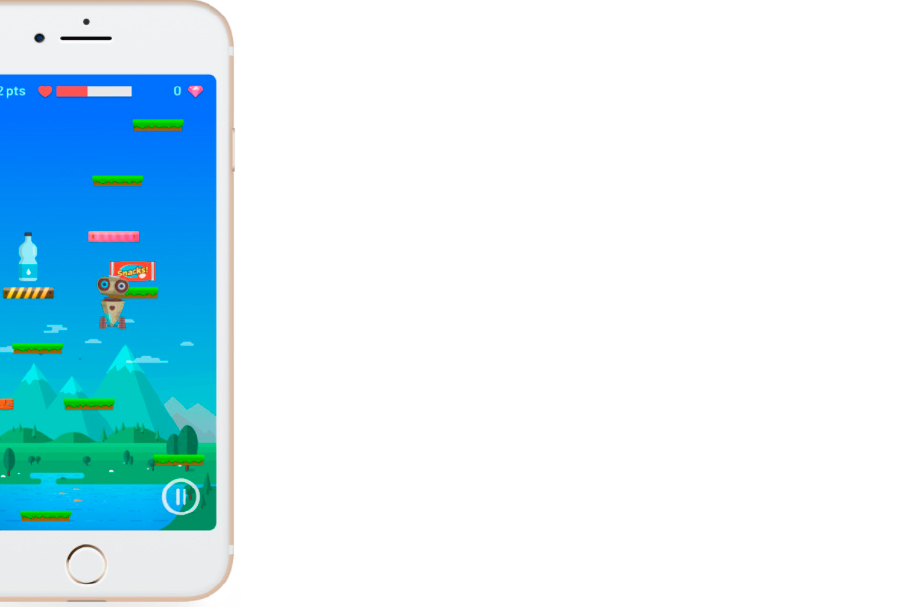
Figure 1. Image of the game (from the website: www.healthyjeart.com, accessed on 26 February 2021).